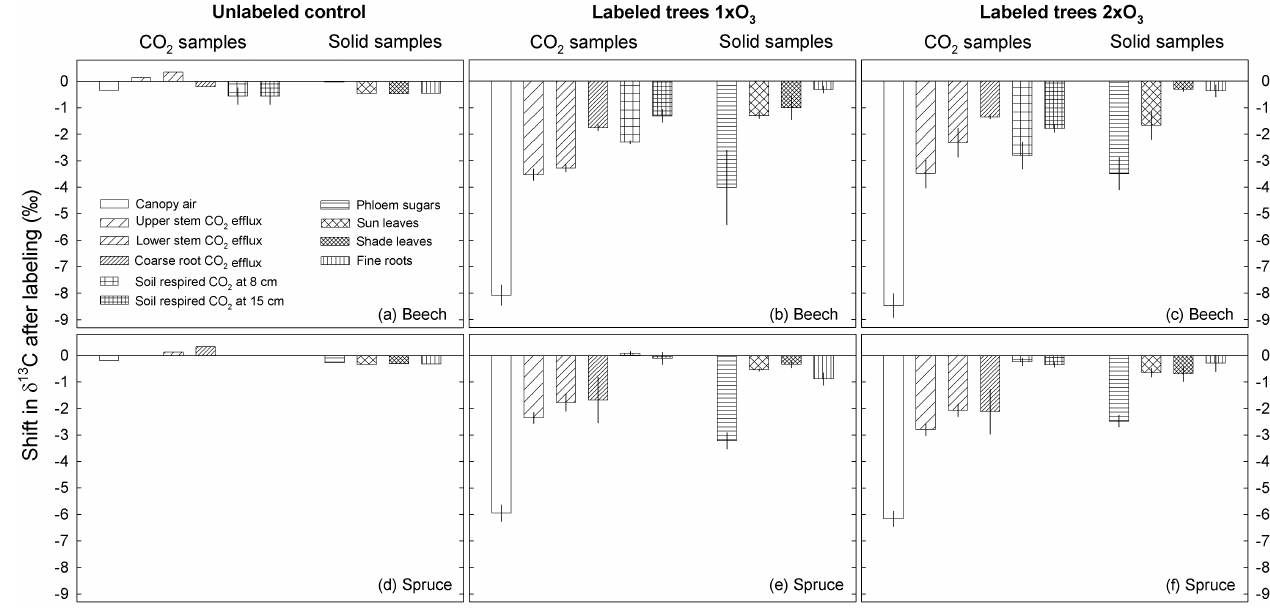
Fig. 4. Shift in δ 13 C of canopy air, upper and lower stem CO 2 efflux, soil respired CO 2 at 8 and 15cm soil depth, phloem sugars, sun and shade leaves as well as fine roots of beech (a–c) and spruce (d–f) after 2.5 weeks of labeling. Data are shown as means ( ± SE) for three labeled trees under 1 × and 2 × O 3 , respectively. In addition, data from one unlabeled control beech and spruce tree are included to confirm no effect of weather conditions on δ 13 C during experimentation. Overall, the t-test for paired comparisons indicated no significant differences in δ 13 C shift between O 3 regimes within CO 2 and solid samples of labeled beech and spruce.